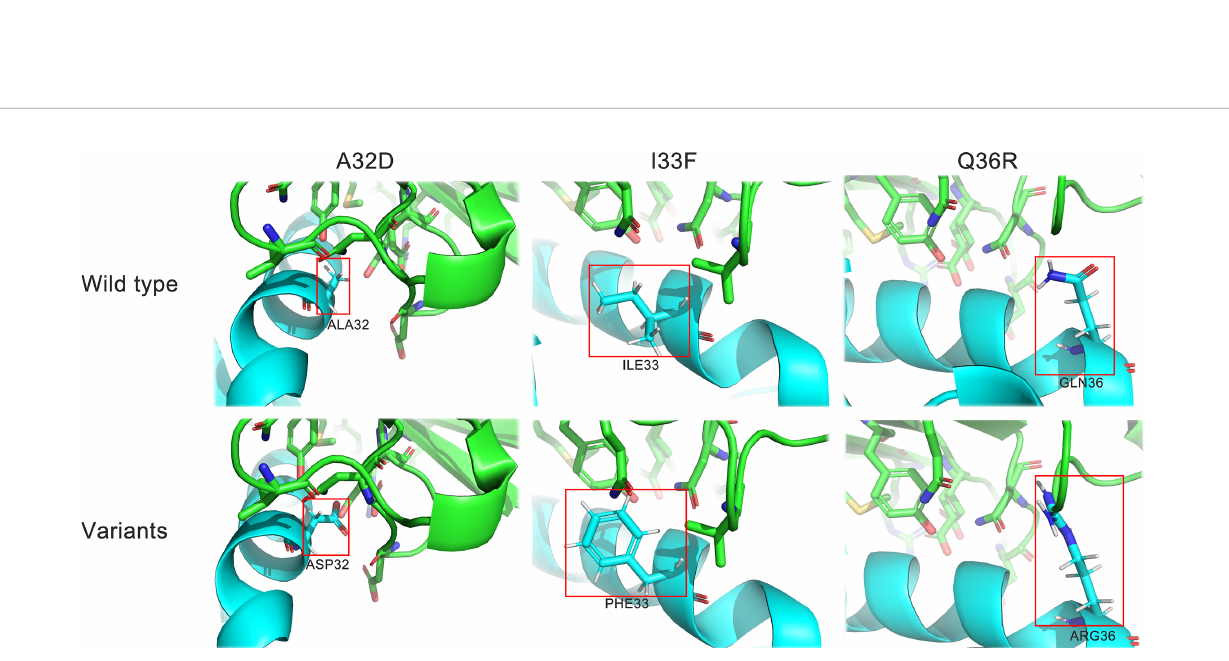
FIGURE 6 | Structure details of the variants. Cyan, U1 snRNPA; green, PD-L1. Stick representations in the red box show the mutated